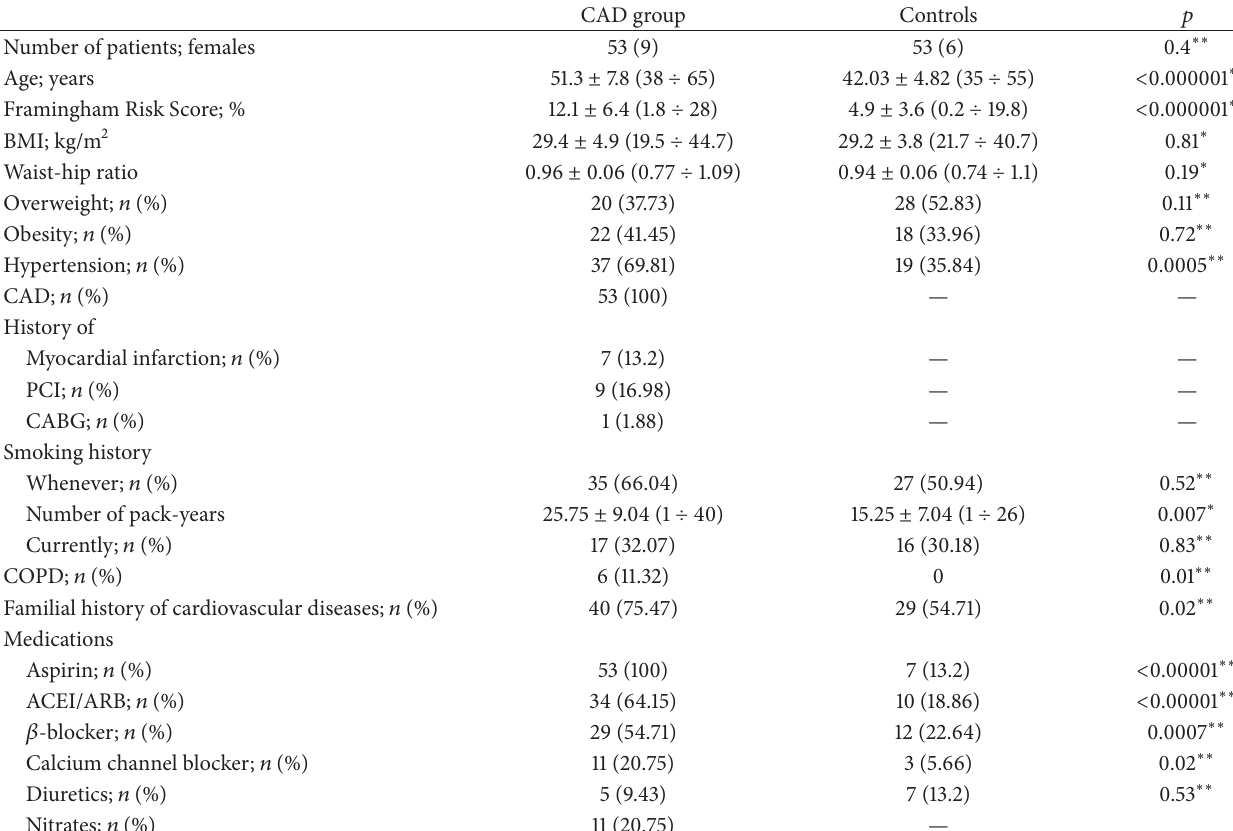
Table 1: Characteristics of the study groups. CAD group